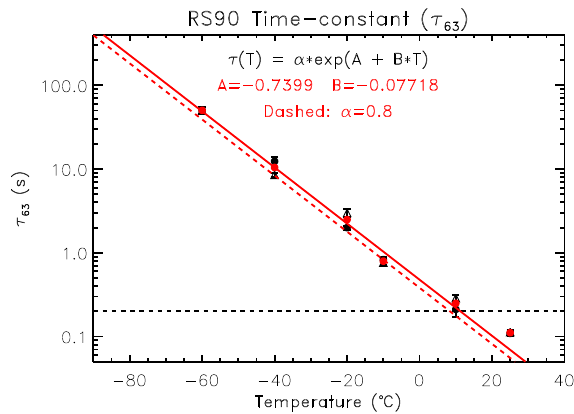
Figure 13. Comparison of night-time humidity profiles from RS92 Figure 14. RS90 and RS92 RH sensor time constant as a function of Fig.13. ComparisonofnighttimehumidityprofilesfromRS92andcoincidentcryogenicfrostpointhygrometer Fig. 14. RS90 and RS92 RH sensor time constant as a function of temperature from Vaisala laboratory mea- and coincident cryogenic frost point hygrometer (CFH) data taken temperature from Vaisala laboratory measurements. The black data (CFH) data taken in 2010 in Lindenberg (blue) and Yangjiang (grey). The RS92 data were corrected for radia- surements. The black data points are the same as in Fig. 2 of Miloshevich et al. (2004), where the circles in 2010 in Lindenberg (blue) and Yangjiang (grey). The RS92 data points are the same as in Fig. 2 of Miloshevich et al. (2004), where tion dry bias and time-lag using the GRUAN correction algorithms. The red squares represent the temperature and triangles represent the mean time constants for increasing RH and decreasing RH, respectively. The red were corrected for radiation dry bias and time-lag using the GRUAN the circles and triangles represent the mean time constants for in- dependent calibration correction that is derived from these data. symbols are the average of the time constant values for increasing and decreasing RH. The exponential fit is correction algorithms. The red squares represent the temperature- creasing RH and decreasing RH, respectively. The red symbols are based on the average of the time constant values for increasing and decreasing RH (red circles). The data point dependent calibration correction that is derived from these data. the average of the time-constant values for increasing and decreas- at +25 ◦ C is not used in the fit. The scale factor α =0.8 (dashed line) corresponds to about 2 standard deviations ing RH. The exponential fit is based on the average of the time- below the mean, meaning that 95% of sensors will be slightly under-corrected and 5% will be overcorrected constant values for increasing and decreasing RH (red circles). The (i.e., a conservative approach). The plot was provided by L. Miloshevich. data point at + 25 ◦ C is not used in the fit. The scale factor α = 0.8 (dashed line) corresponds to about 2 standard deviations below the mean, meaning that 95% of sensors will be slightly under-corrected and 5% will be overcorrected (i.e. a conservative approach). The plot was provided by L.